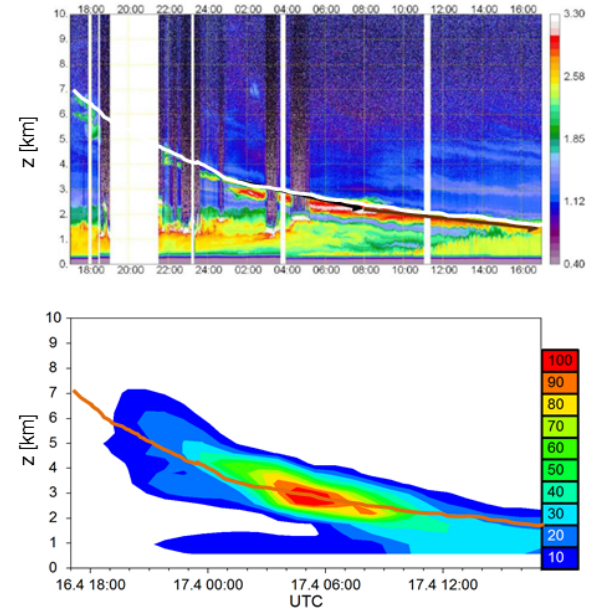
Figure 8. Top: logarithm of range-corrected signal of multi- wavelength lidar system (MULIS) at = 1064nm at Maisach from 16 April 2010, 17:00UTC to 17 April 2010, 17:00UTC and from 0 to 10km above ground; white areas denote periods without mea- surements (taken from Gasteiger et al., 2010). The thick white line shows the hand drawn border of the top of the ash plume based on the observations. Bottom: simulated cross sections in µm 2 m − 3 for the size bins 1, 3, 5, 10, and 15µm. The brownish line is a copy of the white line drawn in the measurements into the graph of the model